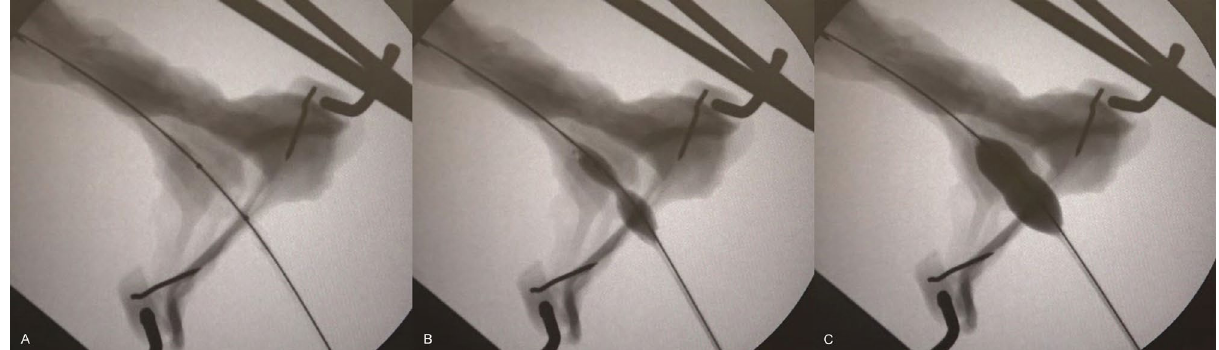
Figure 3. Fluoroscopic images of sphincteroplasty using the novel non-slip balloon in the ex vivo protocol. After the center of the balloon was positioned over the papilla ( A ), the balloon was inflated gradually. The central part of the balloon was expanded in a delayed manner ( B ), and full expansion of the balloon was achieved strictly without slippage ( C